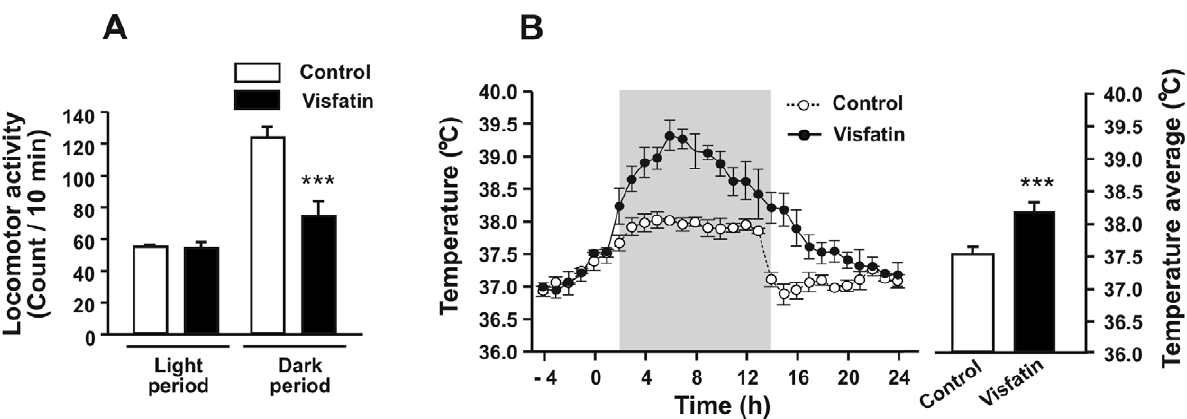
Figure 2. Effects of visfatin on locomotor activity and body temperature. Locomotor activity and body temperature were measured for 24 h after ICV administration of visfatin. (A) ICV injection of visfatin resulted in decreased locomotor activity during the dark period, but there was no change in activity during the light period. (B) Body temperature began to increase 2 h after ICV injection of visfatin and remained high until about 20 h after injection. Mean temperature after the injection time (at 0 h) was significantly different between groups. Data are represented as mean 6